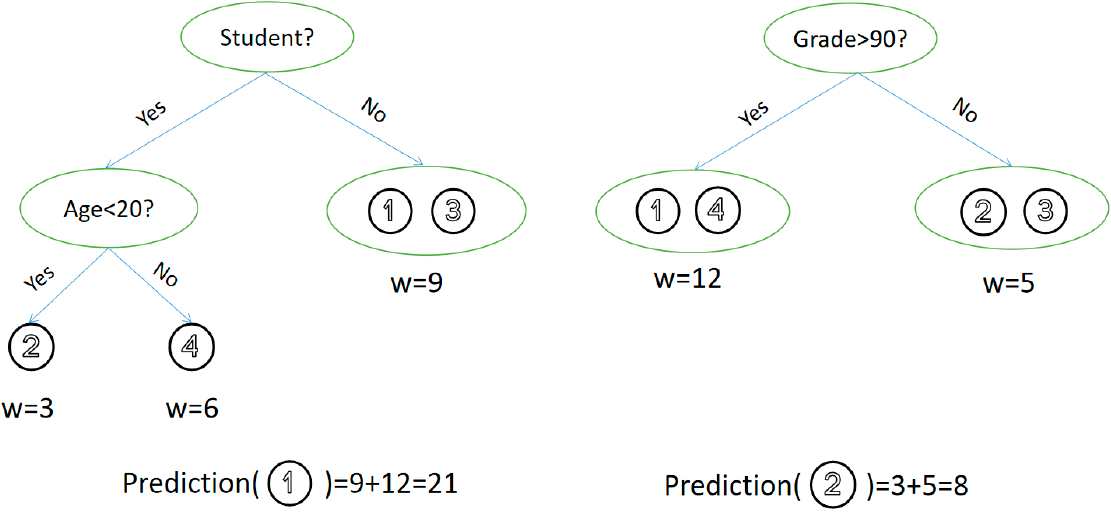
Figure 1. An example of GBDTs.